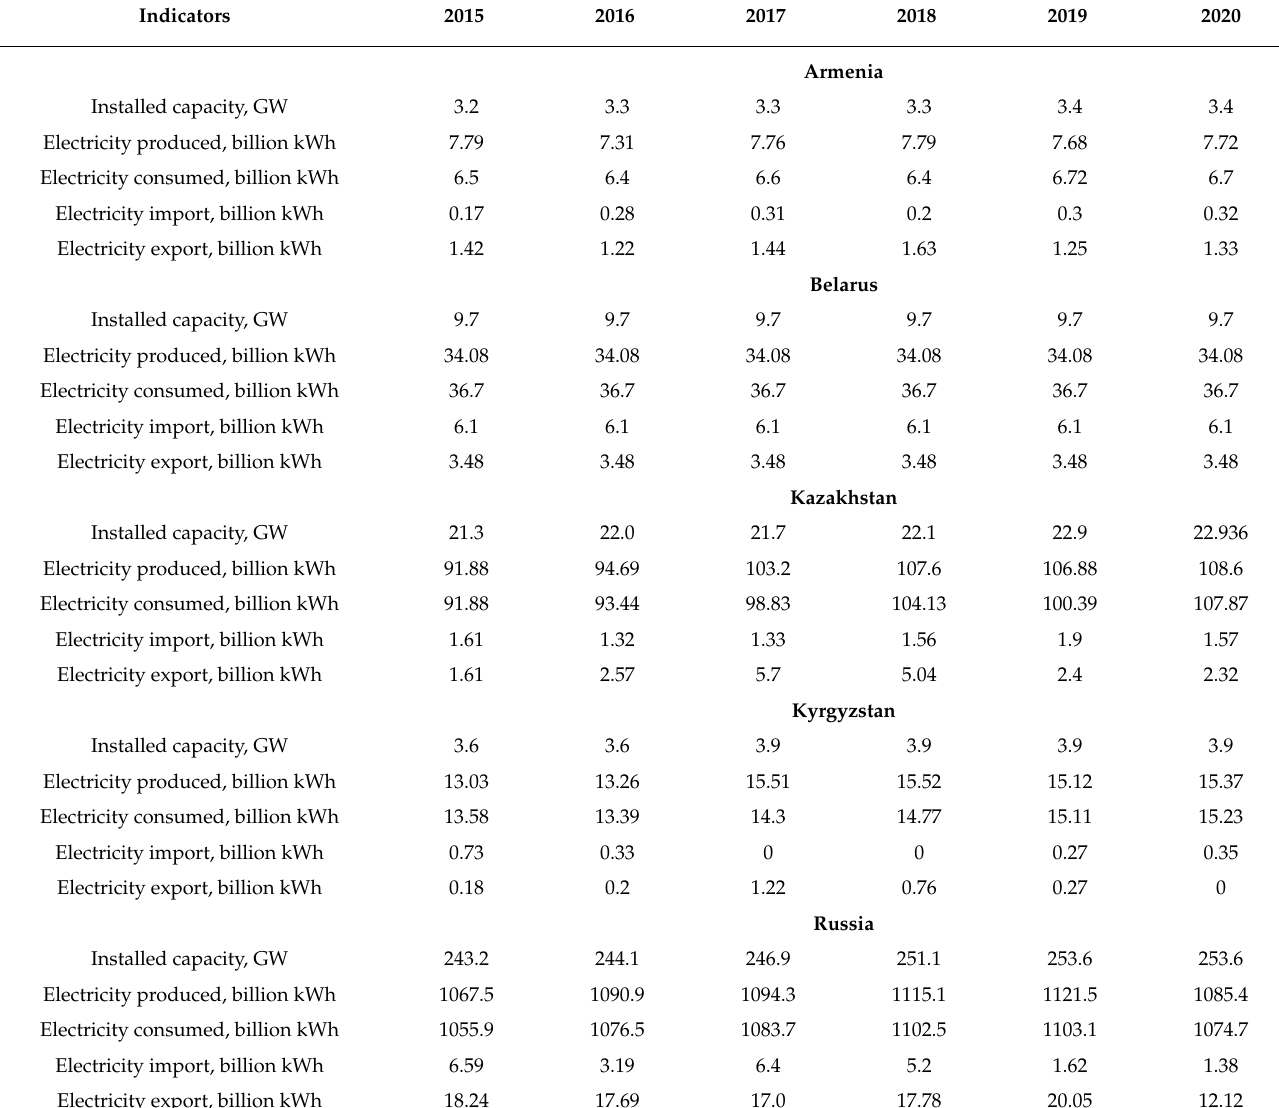
Table 3. Power balance of the countries participating in the EAEU common electric power market, billion